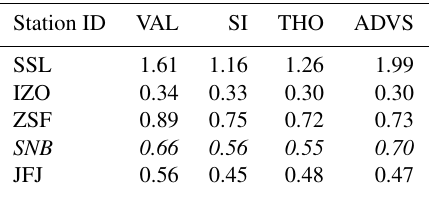
Table 4. Standard deviations of the remainder components by STL over 2010 to 2015, except for SNB. Data at SNB were decomposed over 2012 to 2015 due to missing data from 2010 to 2011 and thus shown in italic